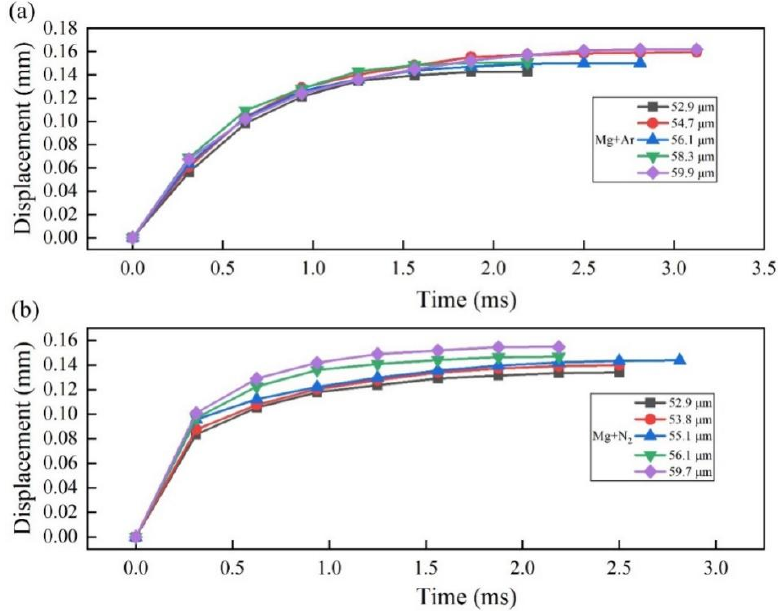
Figure 7. The propagation displacements of the front of the shock wave ( a ) in Ar; ( b ) in N 2 . In each atmosphere, the phenomena of multiple individual Mg microparticles with different diameters ( d p ) were repeatedly recorded, and the coefficients in Equation (5) and the correlation coefficients (R) for fitting are listed into Table 1. The coefficient k in Ar is smaller than that in N 2 , which suggests that the loaded internal pressure due to the phase transition in N 2 was higher than that in Ar. In the early propagation stage, if the data in Figure 7 were fitted by a linear function, the propagation velocity of the shock wave in Ar ranged from 0.158~0.175 m/s, which is much lower than that in N 2 , which ranged from 0.266~0.322 m/s. The data in Table 1 show that at under the same operation conditions, the propagation velocity had a weak correlation with the initial diameter of the Mg mi- croparticle. Table 1. The fitting coefficients and correlation coefficients in Equation (5).